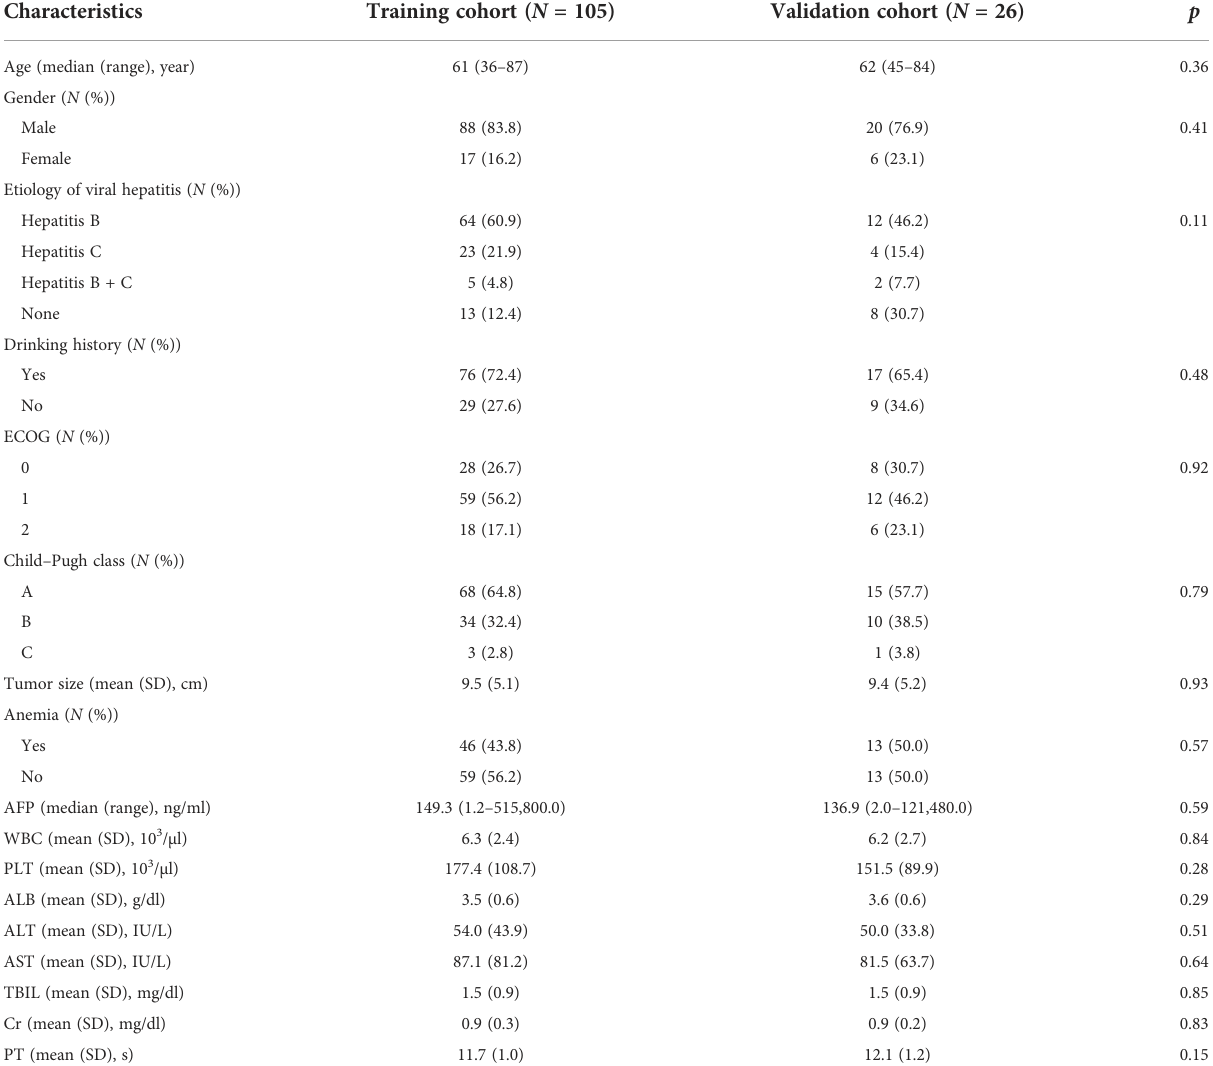
TABLE 2 Baseline characteristics of the training and validation